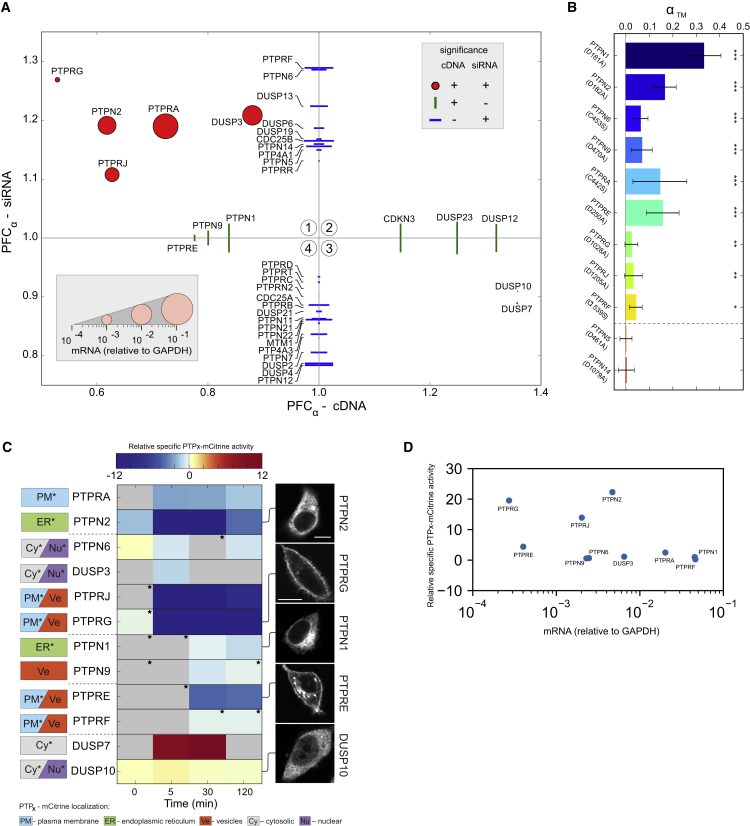
In Situ EGFR Phosphatome Identification(A) Scatterplot of median EGFR phosphorylation fold changes (PFCα=αPTP/αctr, n ∼ 150 cells per condition) upon siRNA knockdown (PFCα − siRNA) and ectopic PTPX-mCitrine expression (PFCα − cDNA), 5 min after 200 ng/mL EGF stimulation. Significant PFCα upon both (red dots) or only one perturbation (green/blue lines, p < 0.05) are shown. Marker length is scaled to relative PTPX-mRNA expression in MCF7 cells (legend: bottom inset and Figure S1A).(B) Average fraction of EGFR-mTFP interacting with catalytically impaired PTPX-mCitrine trapping mutants (αTM ± SD, n = 15–20 cells, N = 2; ∗p < 0.05, ∗∗p < 0.01, ∗∗∗p < 0.001) following 200 ng/mL 5P-EGF.(C) Relative specific PTPX-mCitrine activities prior to and 5, 30, and 120 min after 200 ng/mL 5P-EGF stimulation (middle). Asterisks denote weak linear dependencies (Figure S2D). Subcellular localization of PTPX-mCitrine (asterisks in left-hand boxes: additionally curated localization from LOCATE/UniProt database) and exemplary fluorescence images (right; scale bars, 10 μm).(D) Relative specific PTPX-mCitrine activities versus the corresponding mRNA expression in MCF7 cells.